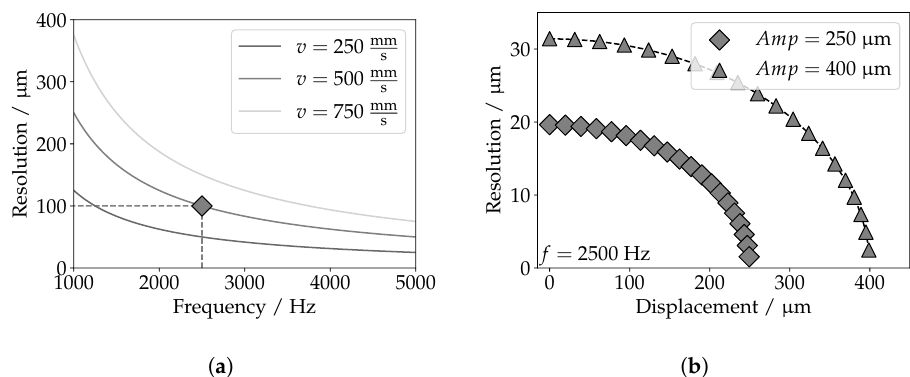
Figure 11. ( a ) Resolution in welding direction as a function of the modulation frequency; ( b ) resolu- tion perpendicular to the welding direction as a function of the distance from the middle axis.